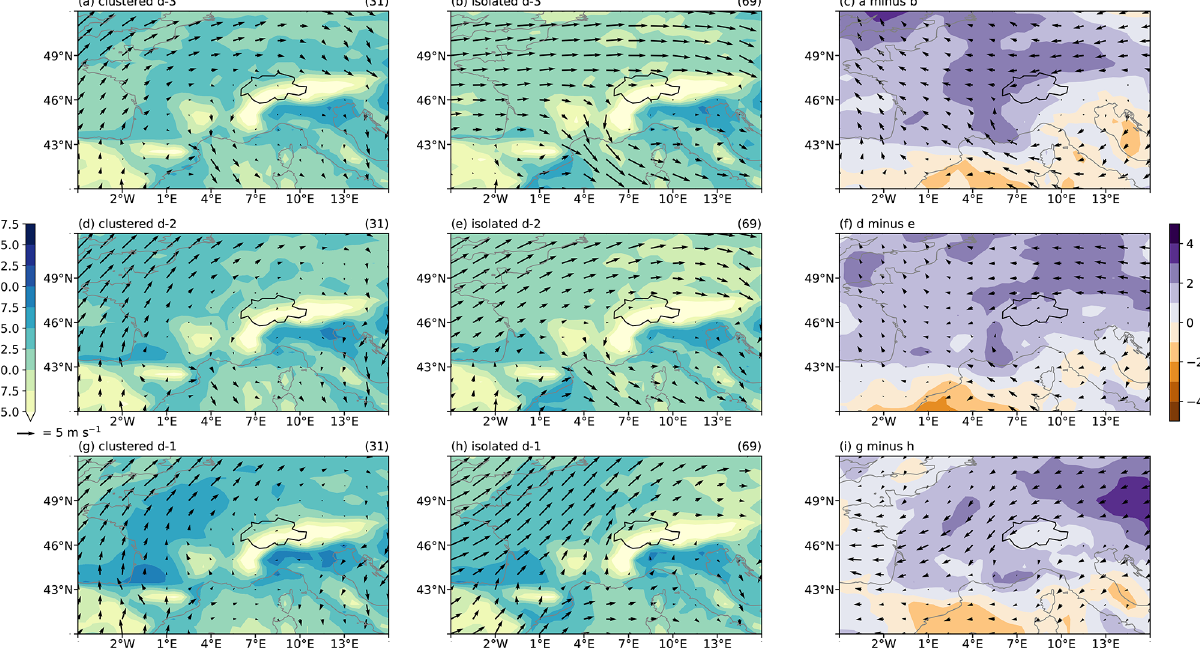
along the southern edge of the Alps (Fig. 10e), and there